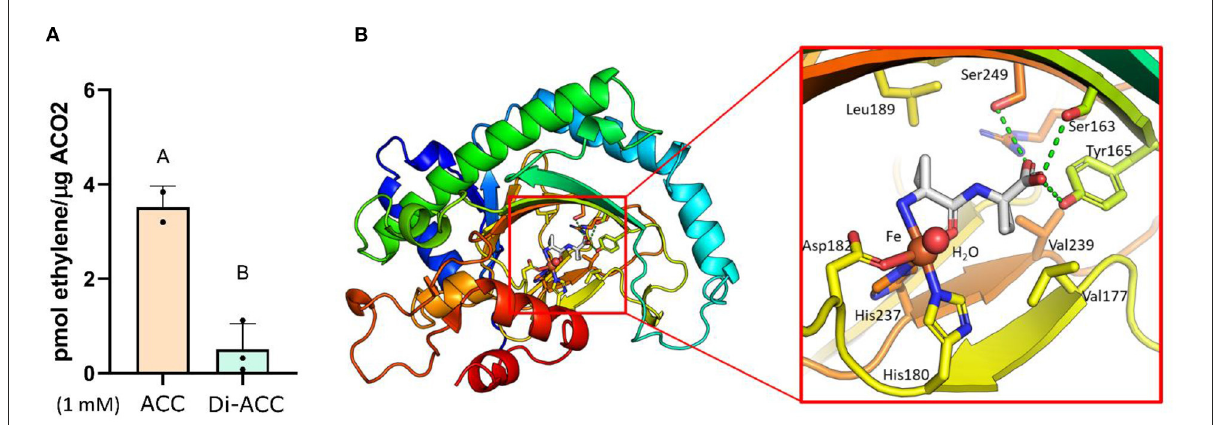
FIGURE4 Di-ACC acts as a substrate for ACO to form ethylene, with lower efficiency than ACC. (A) In-vitro ethylene production using recombinant purified AtACO2 with ACC or di-ACC as substrate ( n = 3). (B) Simulated binding of di-ACC in the catalytic core of AtACO2. The right panel shows a close-up of the catalytic site in which the ACC dimer is superimposed with free ACC (shown in gray with blue amino groups and red carboxyl groups) and the Fe-metal co-factor in red. Important residues that facilitate substrate docking are indicated with amino acid numbers. Hydrogen bonds are shown as green dotted